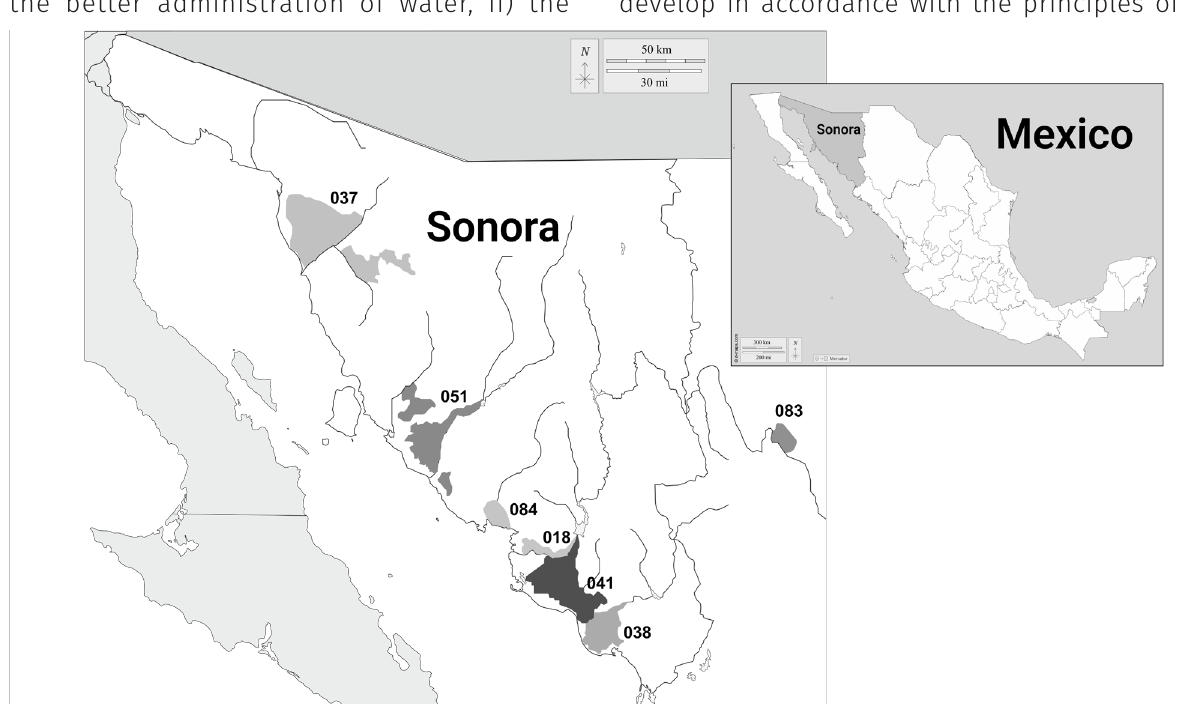
Figure 1. Irrigation districts of the North West Basin Agency. Source: Own